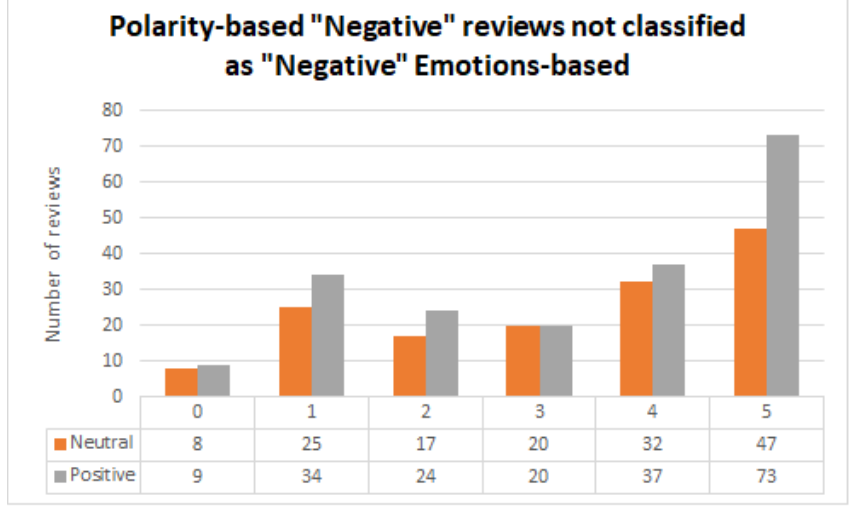
Figure 9. Review classes considering emotion-based classification and polarity-based classification.